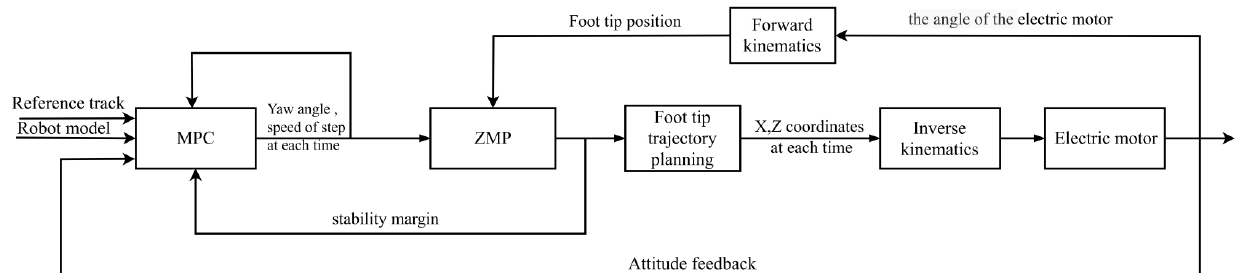
Figure 1. The flow diagram of gait stability control.